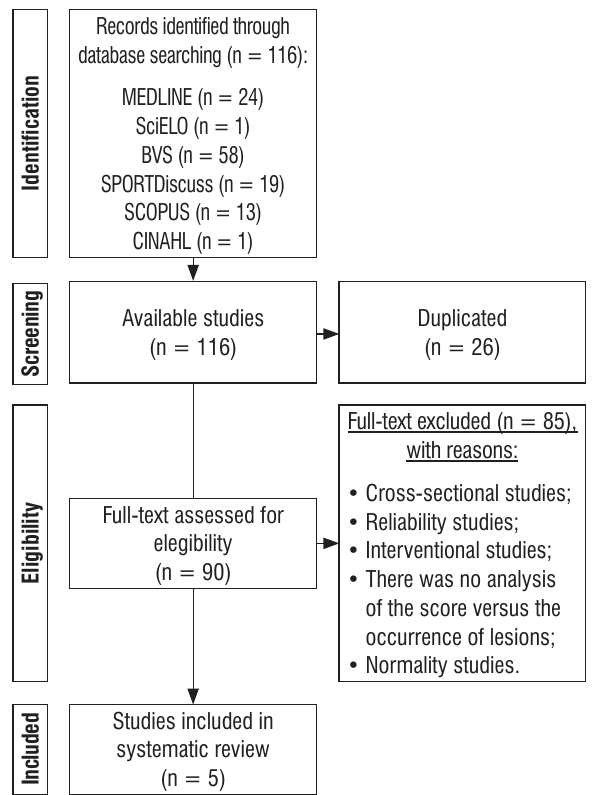
Figure 1 - Flow diagram of the included